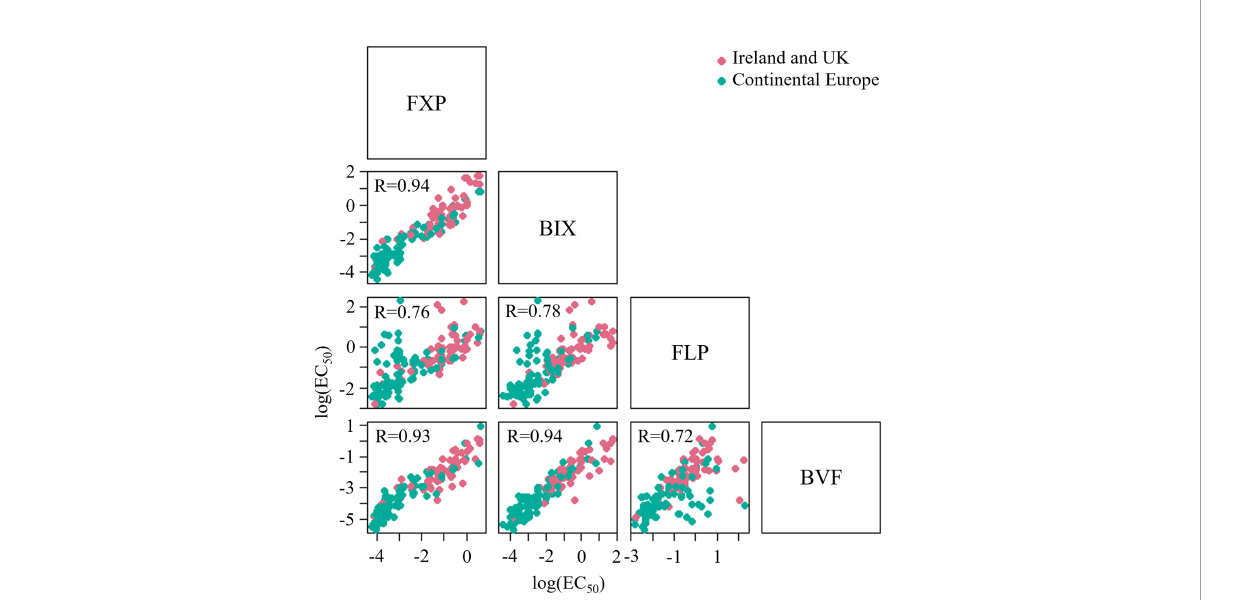
FIGURE 9 Cross-resistance between SDHI fungicides based on sensitivity data (EC 50 ) from 3 seasons and 202 Z. tritici isolates. Samples were collected from trials located in Ireland and UK, and continental Europe, including Denmark, Germany, Belgium, France and